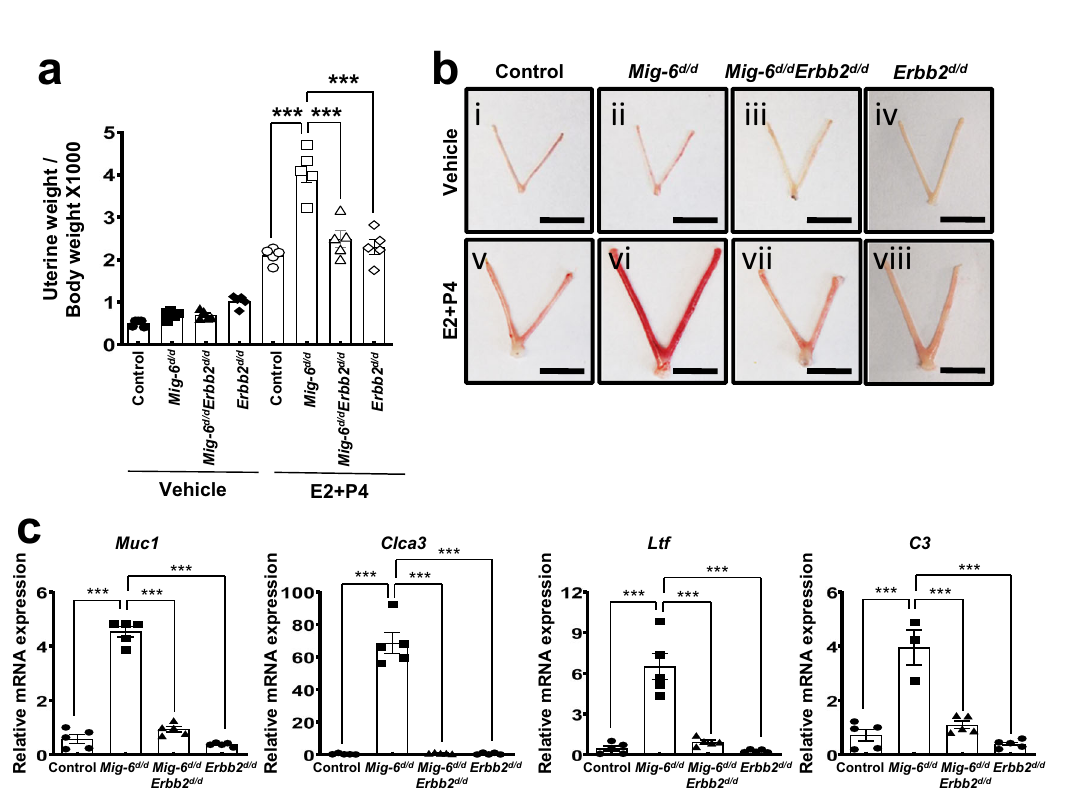
Fig. 5 Rescue of steroid hormone dysregulation in Mig-6 d/d mice by Erbb2 double ablation. a , b Ratio of uterine weight to body weight ( a ) and uteri ( b ) of control, Mig-6 d/d , Mig-6 d/d Erbb2 d/d , and Erbb2 d/d mice treated with vehicle or E2 + P4 for 3 days ( n = 5 per genotype). Data are represented as mean ± SEM, *** p < 0.0001 by Ordinary one-way ANOVA test. Scale bars: 1 cm ( c ), RT-qPCR analysis of epithelial ESR1 target genes expression, Muc1 , Clca3 , Ltf , and C3 in the uteri of control, Mig-6 d/d , Mig-6 d/d Erbb2 d/d , and Erbb2 d/d mice treated with E2 + P4 for 3 days ( n = 5 per genotype). Data are represented as mean ± SEM, *** p < 0.0001 by Ordinary one-way ANOVA test. Three independent experiments were performed for ( a – c ) with similar results. Source data are provided in the Source Data fi mice in which speci fi c genes can be either eliminated or over- expressed make this induced endometriosis model ideal for studying speci fi c pathways in the development and progression of endometriosis and other diseases 46 . However, current mouse models of endometriosis that involve ovariectomy and E2 treat- ment are impractical for studies of physiological functions that require natural fl uctuations in ovarian steroid hormones, such as fertility. On the other hand, our mouse model alleviates the need to apply ovariectomy and E2 treatment to enlarge endometriotic lesions because fl uorescence reporter genes allow us to visualize in vivo and in real-time endometriotic lesions like those found in humans. Moreover, similarities between our mouse model and human endometriosis include: (1) development and progression of disease; (2) steroid hormone regulation; (3) fertility defect with implantation failure; and (4) P4 resistance in endometrium with Mig-6 de fi ciency. Furthermore, the fl uorescence reporters enable